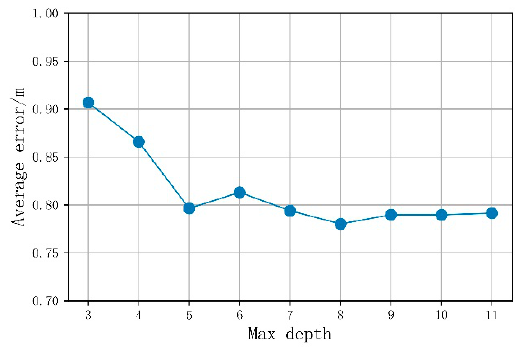
Figure 9. Influence of the maximum depth of the classification regression tree on the average positioning error.